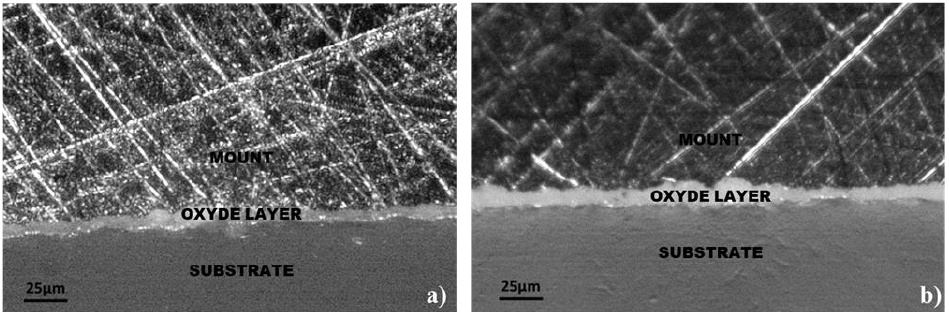
Figure 5. Optical pictures of PEO coating thickness of the ( a ) Mg_PEO15 and ( b ) Mg_PEO30 samples.